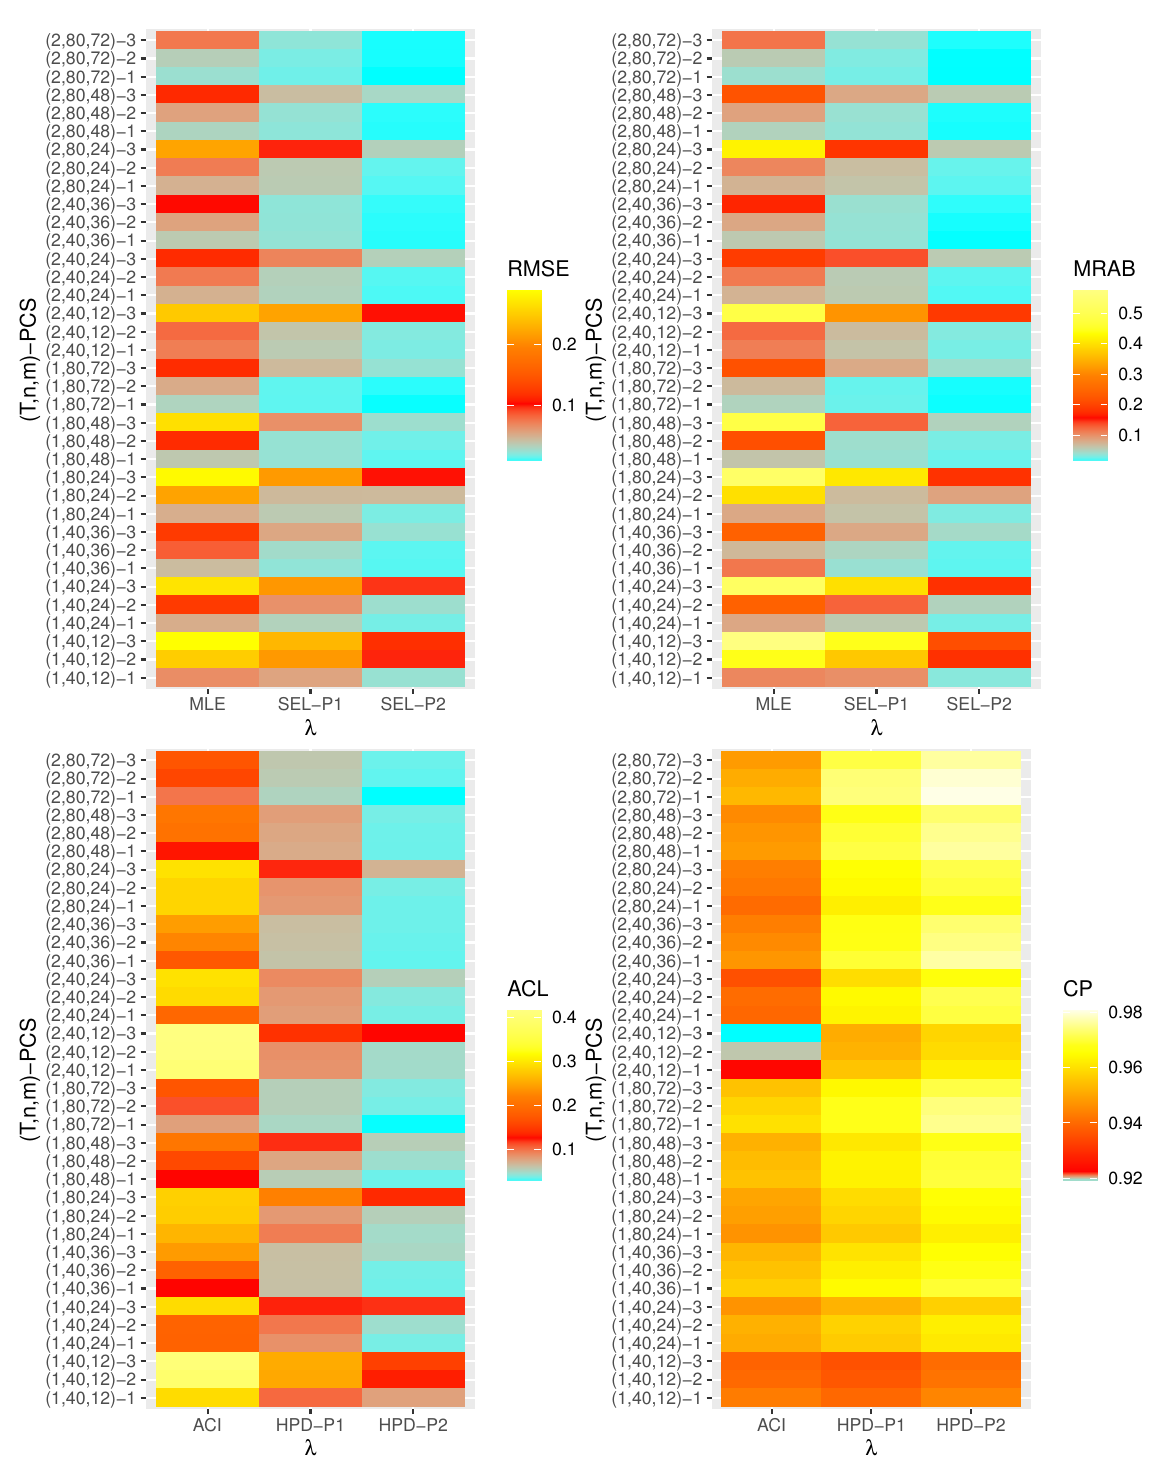
Figure 2. The heatmaps for the estimation results of λ when λ =